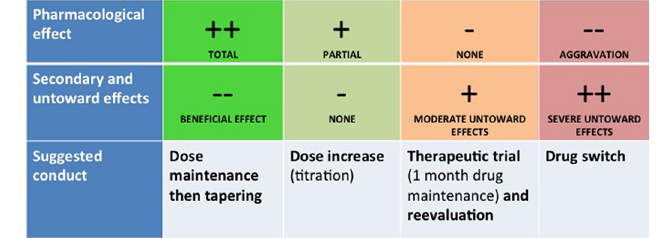
Figure 2. Suggested conduct upon reevaluation between day 15 and